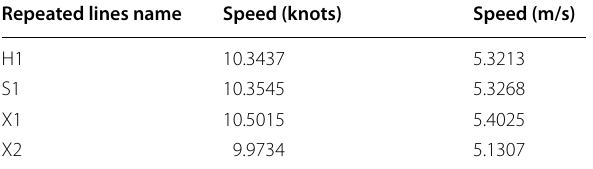
Table 4 The speed of repeated lines Repeated lines